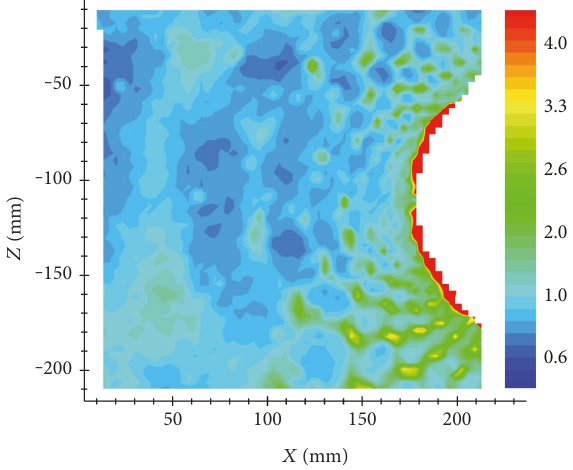
Figure 4: Average fl ow fi eld velocity for the 50 measurements. The airfoil velocity was 90m/s.